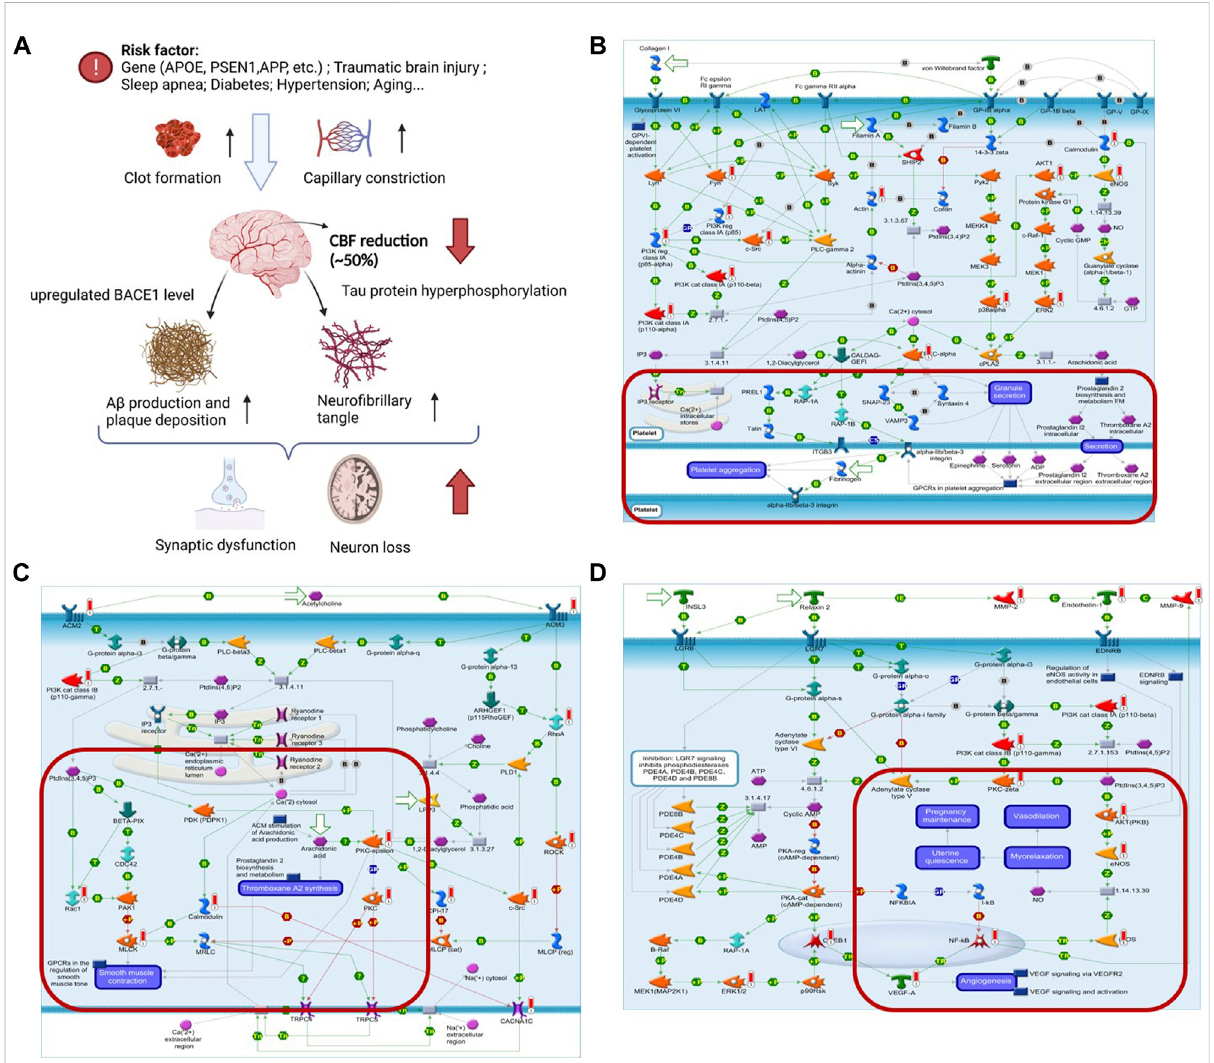
FIGURE 4 YXQNW may promote blood fl ow velocity in AD treatment. (A) Summary of CBF reduction in AD; (B) regulation of blood coagulation_GPIb-IX- V-dependent platelet activation; (C) ACM regulation of smooth muscle contraction; (D) muscle contraction and vasodilation_relaxin signaling pathway. (The red marker is the target of